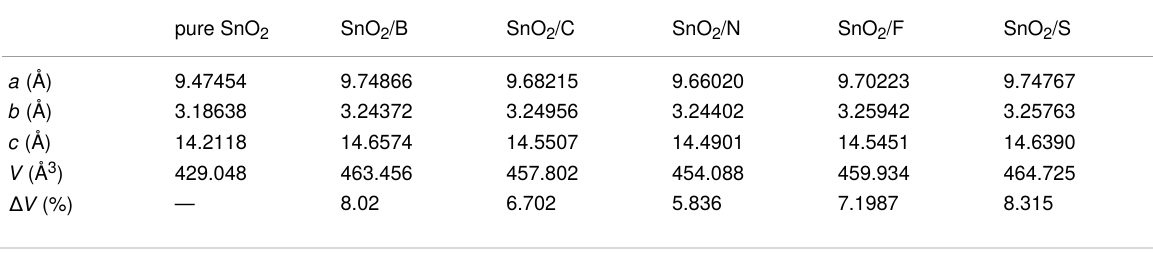
Table 1: Geometric optimization results of SnO 2 with O substituted by a non-metal element.